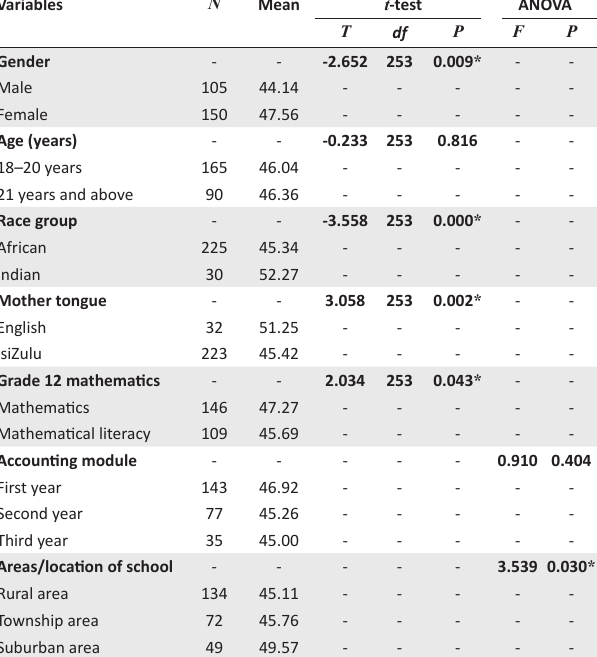
TABLE 6: Comparison: perceived support of mother with variables using means, t -test and ANOVA. Variables